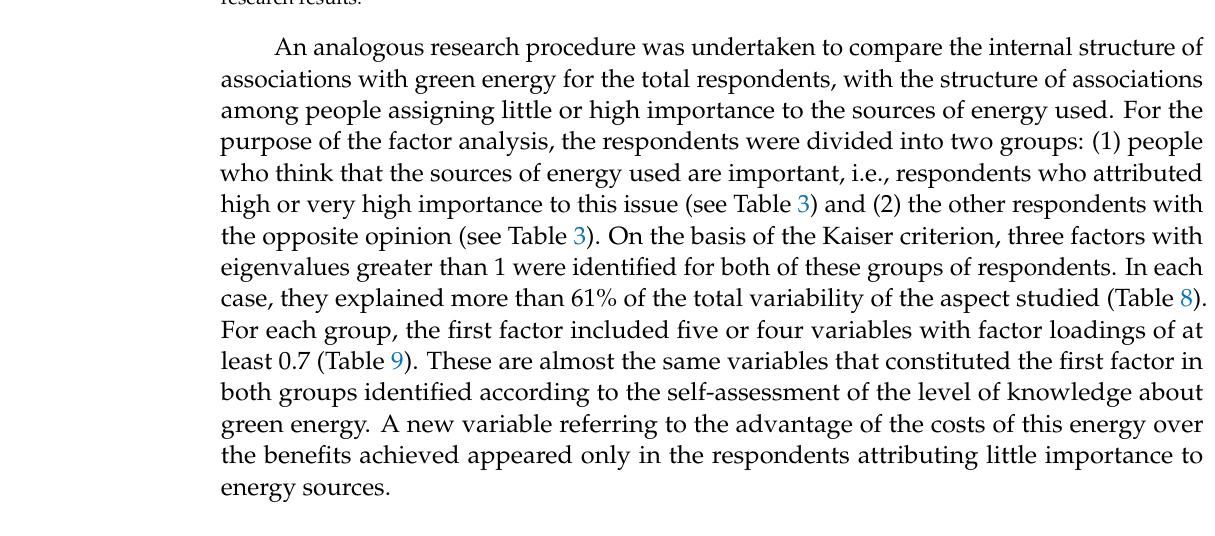
Table 8. Hierarchy of factors according to their eigenvalues determined on the basis of the Kaiser criterion (for the total of respondents and according to the importance assigned to energy